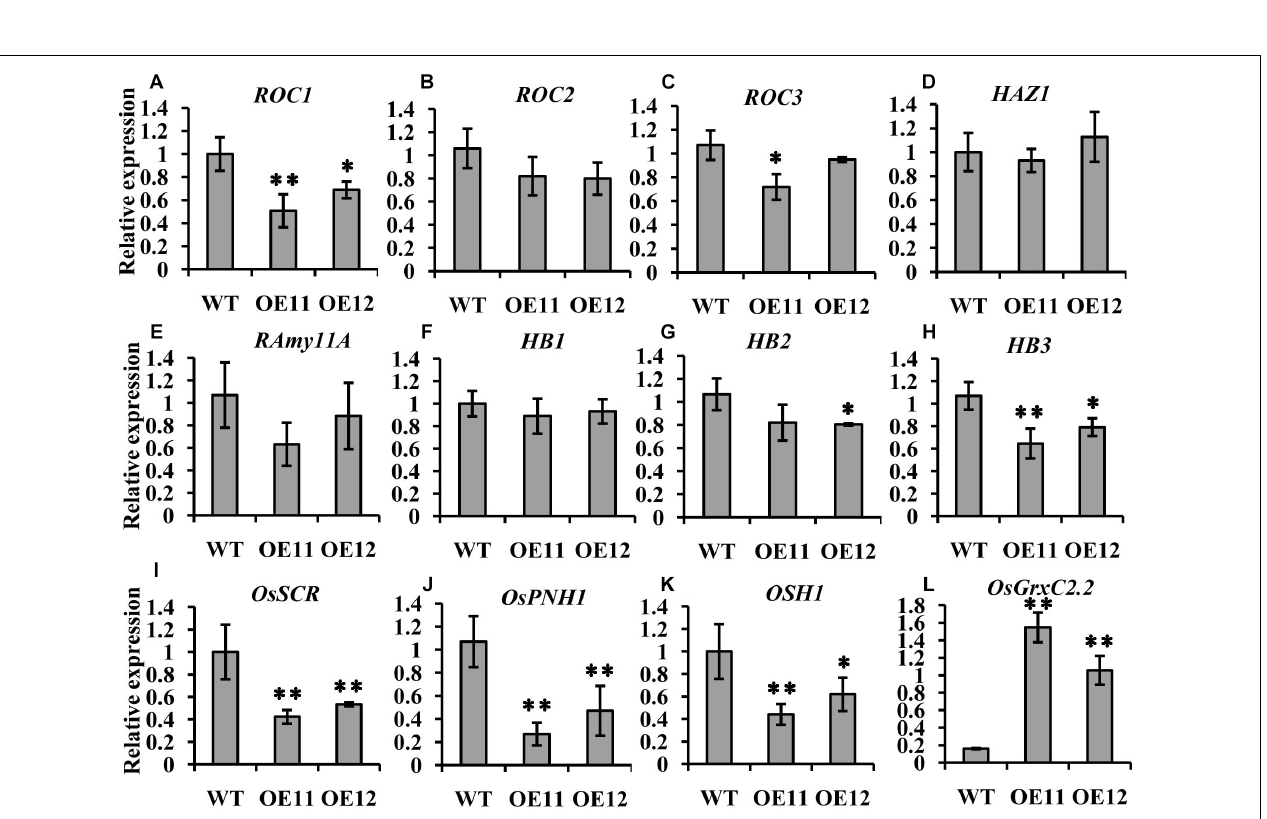
FIGURE 5 | Expression comparison of molecular marker genes between the OsGrxC2.2 -overexpression lines (OE11 and OE12) and the WT control. qRT-PCR of ROC1 (A) , ROC2 (B) , ROC3 (C) , HAZ1 (D) , RAmy11A (E) , HB1 (F) , HB2 (G) , HB3 (H) , OsSCR (I) , OsPNH1 (J) , OSH1 (K) , and OsGrxC2.2 (L) . The y -axis represents the gene expression relative to the OsActin1 transcript level. Results are the averages of three independent experiments. Error bars show the standard deviation. Statistical significance is indicated by ∗∗ p < 0.01 and ∗ p < 0.05.